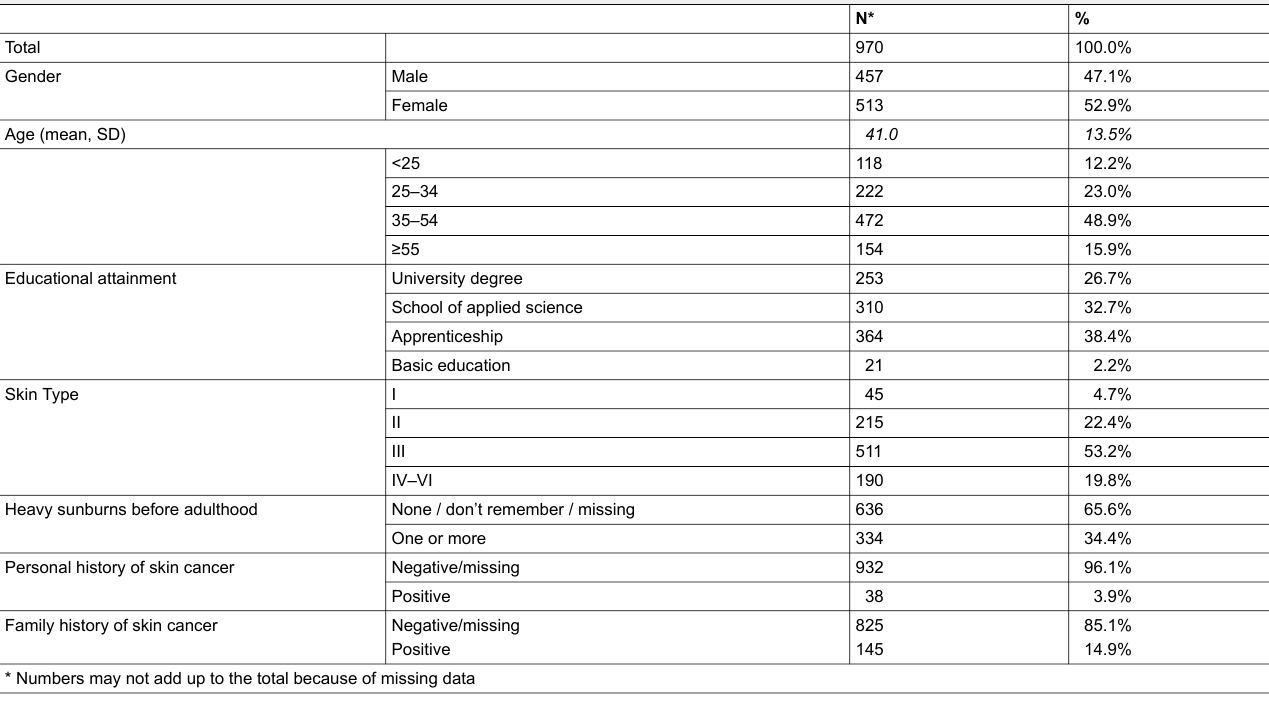
Table 1 : Summarised demographic data of the respondents.